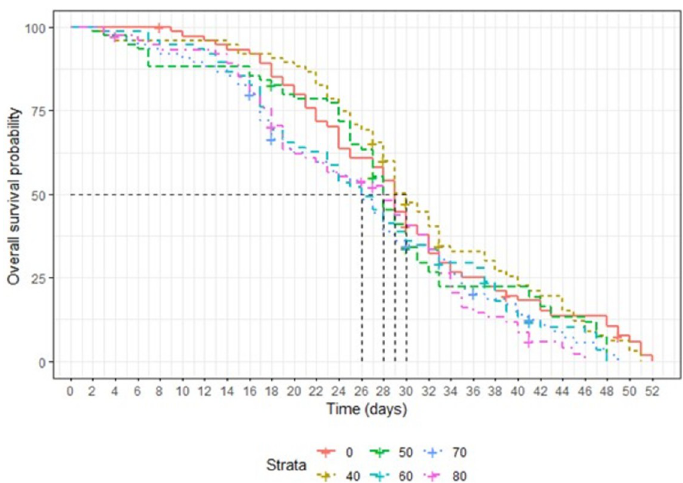
Fig 7. Longevity of non-irradiated and irradiated with different doses of female Ae . aegypti .